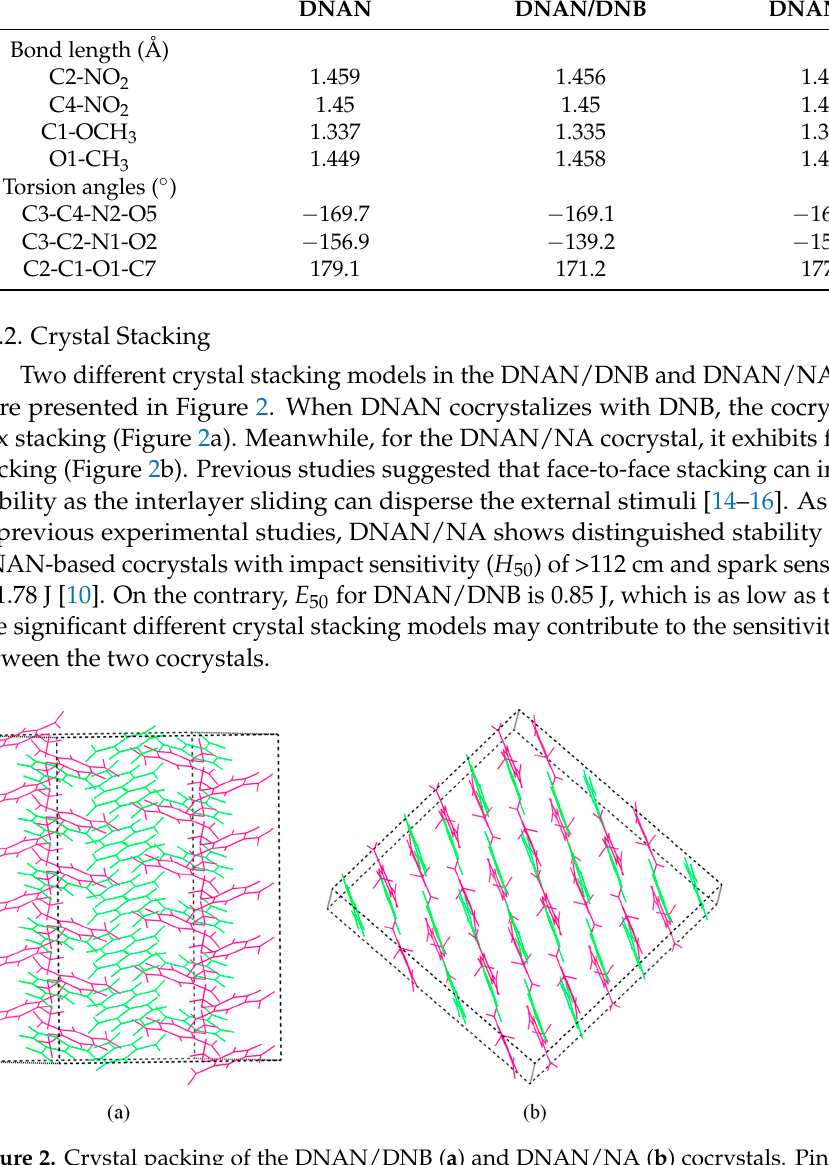
Table 2. Representative bond lengths and torsion angles in the three crystals. DNAN DNAN/DNB